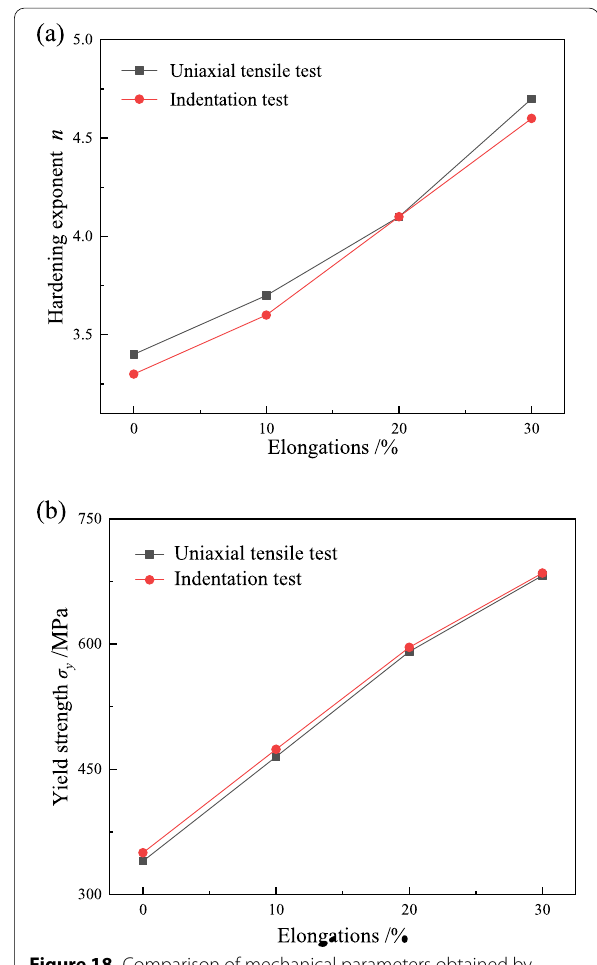
Figure 18 Comparison of mechanical parameters obtained by indentation test and tensile test under different elongations: (a) hardening exponent, (b) yield